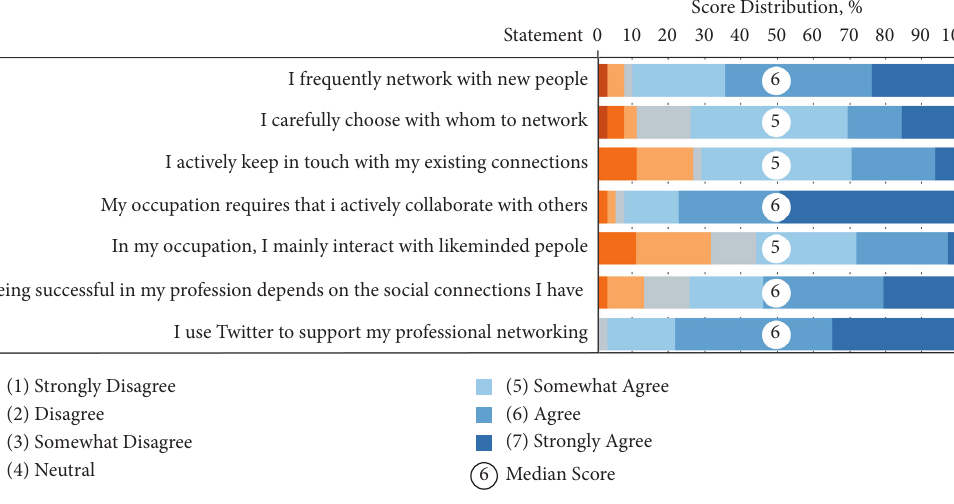
Figure 4: Overview of respondents’ self-reported behavior regarding social and professional